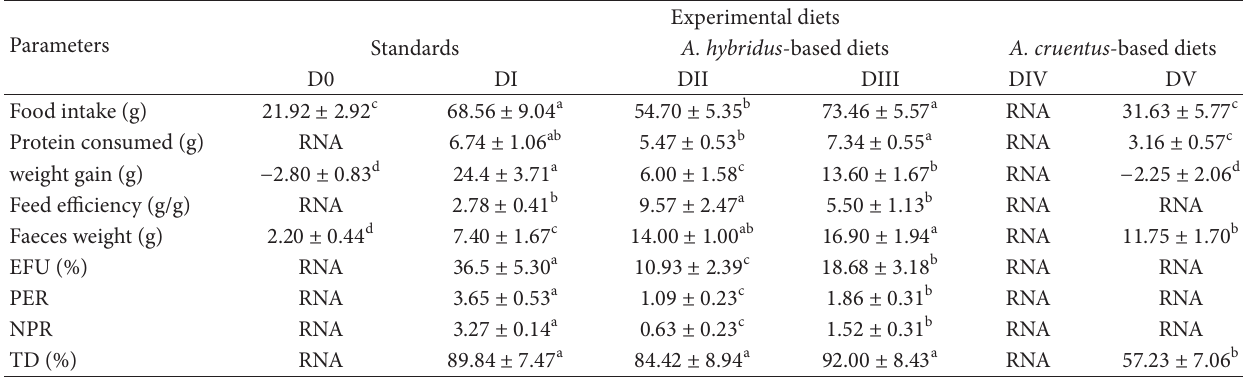
Table 4: Growth performance and protein quality of rats fed with diets containing processed A . hybridus and A . cruentus leaves.